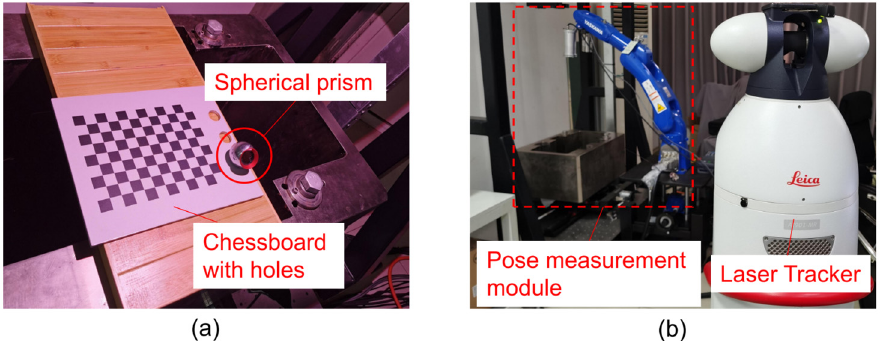
Figure 19. The setup of the accuracy verification experiment: ( a ) Spherical prism and checkerboard; ( b ) Laser tracker and pose measurement module.